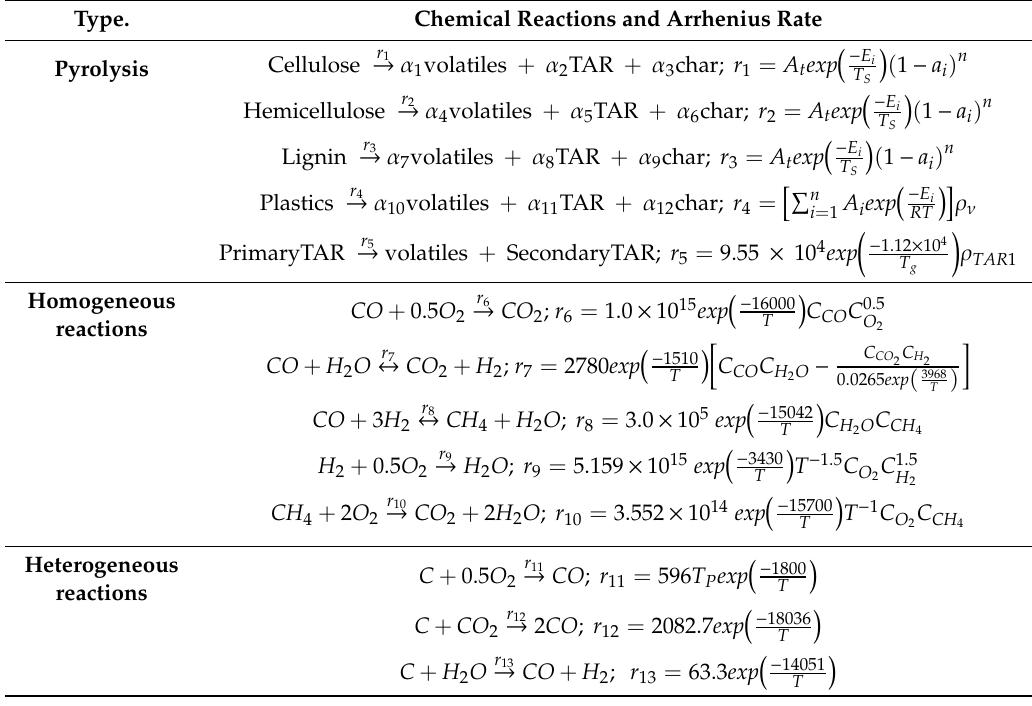
Table 5. Implemented chemical reactions